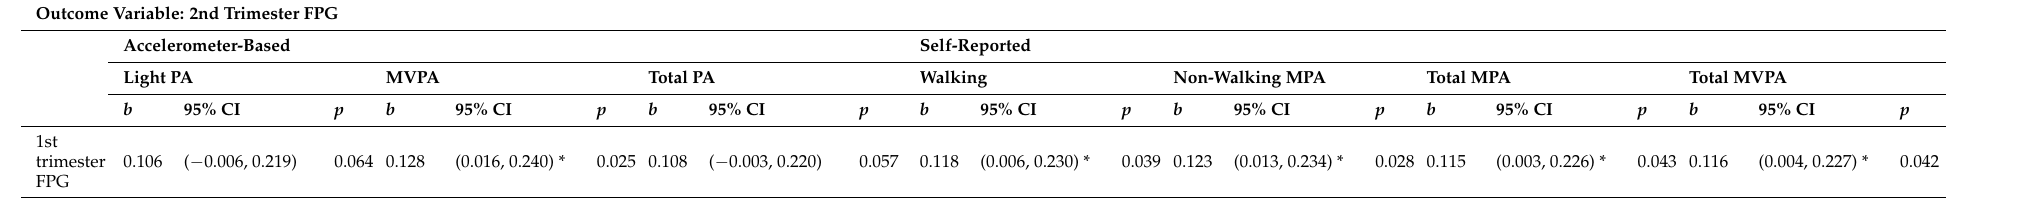
Table 5. Physical activity (PA) adjusted association between 1st trimester FPG and 2nd trimester FPG ( N =